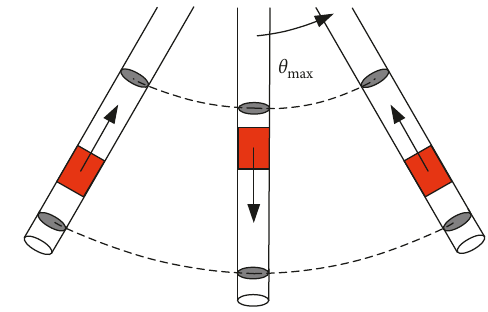
Figure 2: The basic motion of the moving mass that can attenuate the pendulum